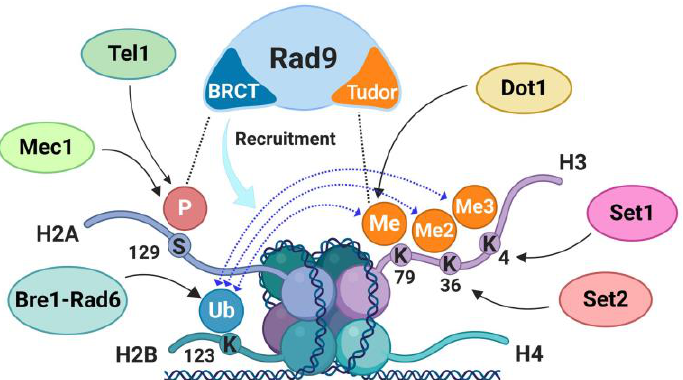
Figure 2. Histone modifications and Rad9 recruitment to DSBs in S. cerevisiae . Rad9 is a master regulator of DSB repair pathway choice and its binding to chromatin is regulated by specific histone modifications, comprising H2A phosphorylation by Tel1 and Mec1, H2B ubiquitylation by Bre1-Rad6 complex and H3 methylation by Set1, Set2, and Dot1. Histone PTMs can generate a docking site for Rad9, which binds to phosphorylated H2A S129 residue ( γ -H2A) through its BRCT motif and to methylated H3 K79 residue through its Tudor domain. Di- and tri-methylation of H3 K4 and K36 residues likely stabilize the interaction between Rad9 and the chromatin by crosstalk with H2B K123 ubiquitylation. Dotted lines represent molecular interactions with histone marks, dotted lines with arrowheads correspond to epigenetic crosstalk. Created with BioRender.com.